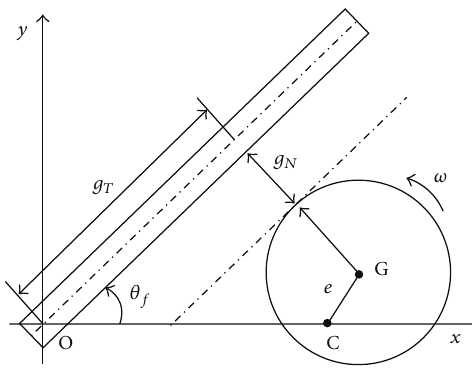
Figure 1: Sketch of cam-follower oblique-impact